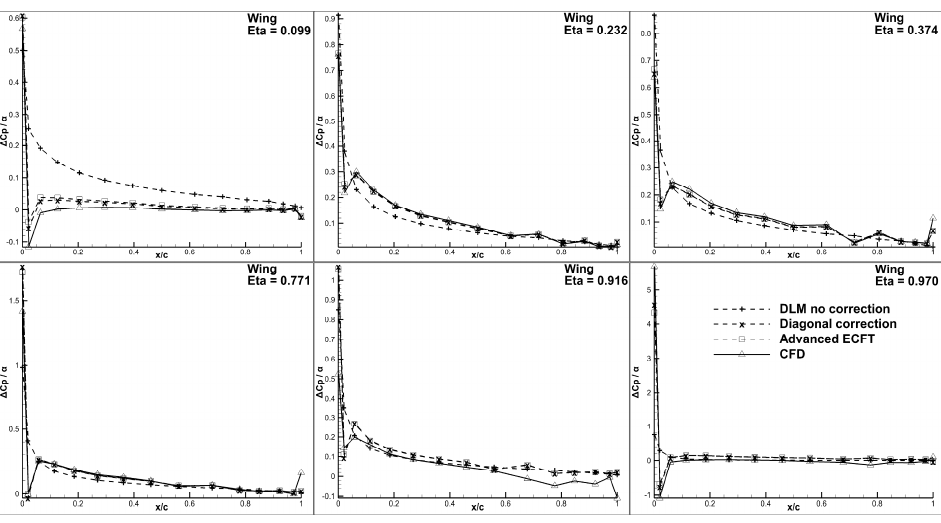
Figure 10. Elastic Δ Cp for a unit α in the horizontal tail, fuselage, and nacelle component.